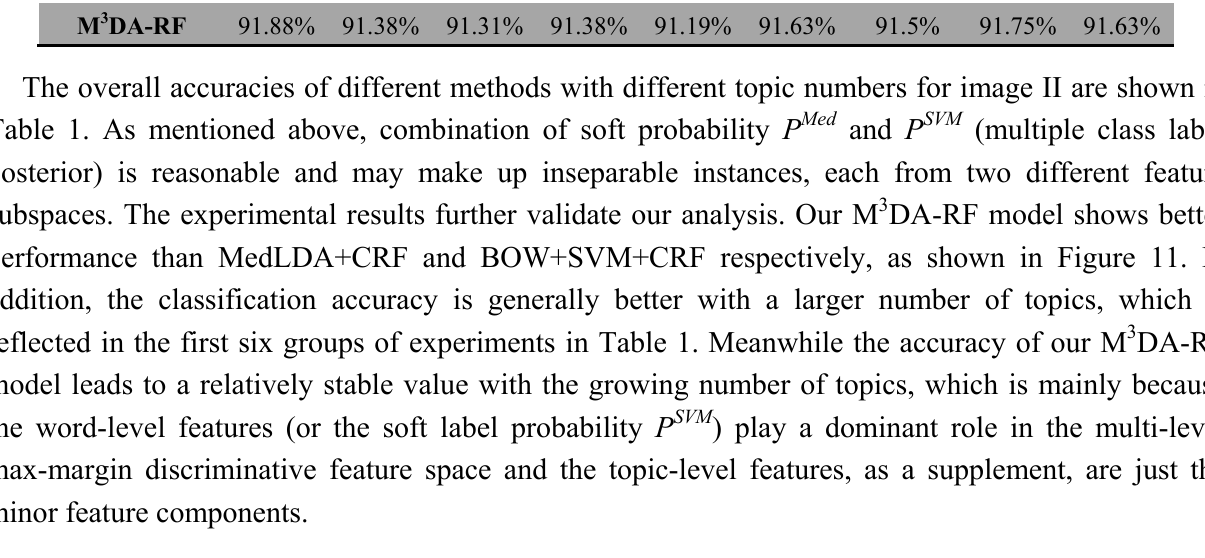
Figure 11. Annotation accuracies of three methods under the condition of different topic numbers. ( a ) Comparison between BOW+SVM+CRF and M 3 DA-RF. ( b ) Comparison between MedLDA+CRF and M 3